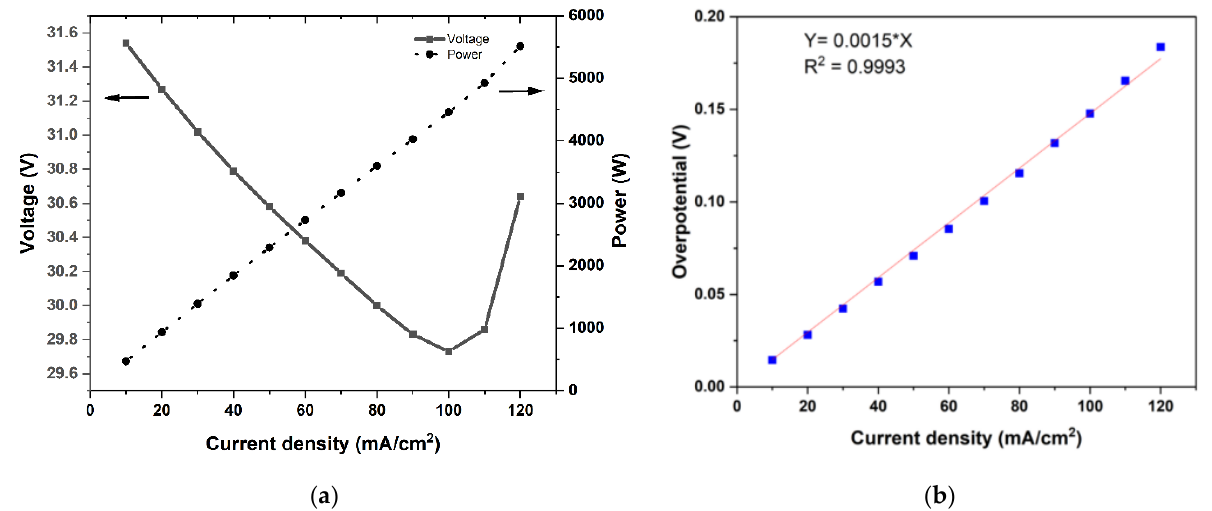
Figure 3. ( a ) The stack power and voltage variation during 45 s discharge pulses at a current density in the range of 120 mA/cm 2 to 10 mA/cm 2 , and ( b ) the polarization curve deduced from data in ( a ), together with the measured open-circuit voltage before and after each